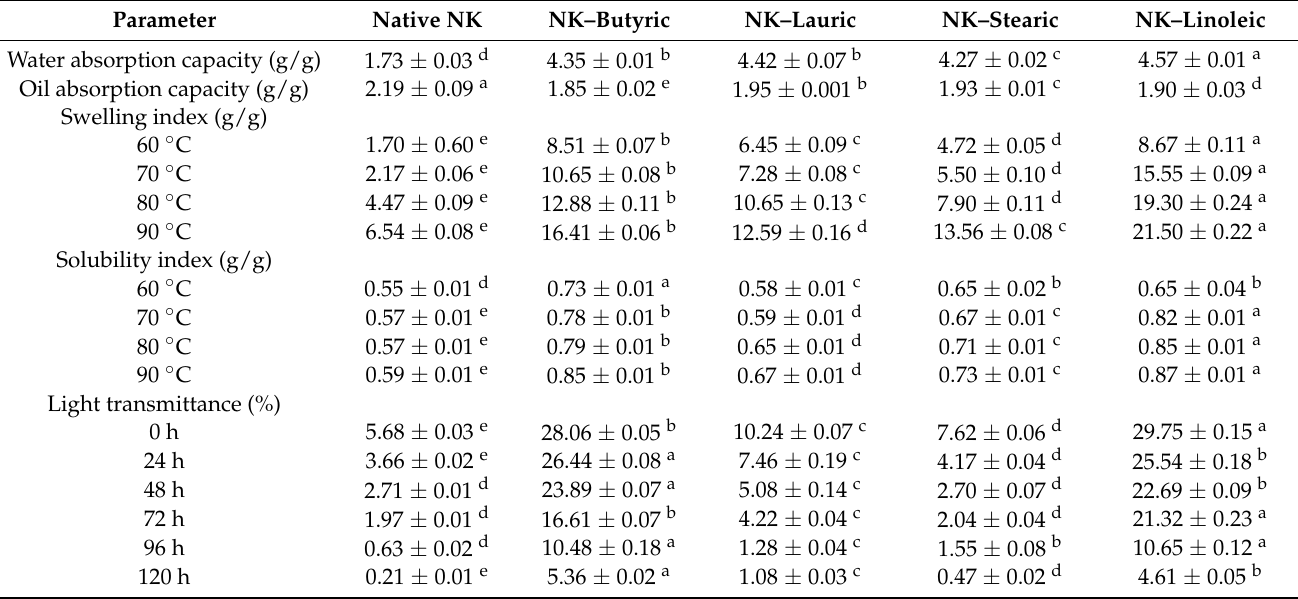
Table 1. Physico-chemical properties of native Noui Khuea (NK) starch and NK starch–lipid complexes with varying fatty acid chain